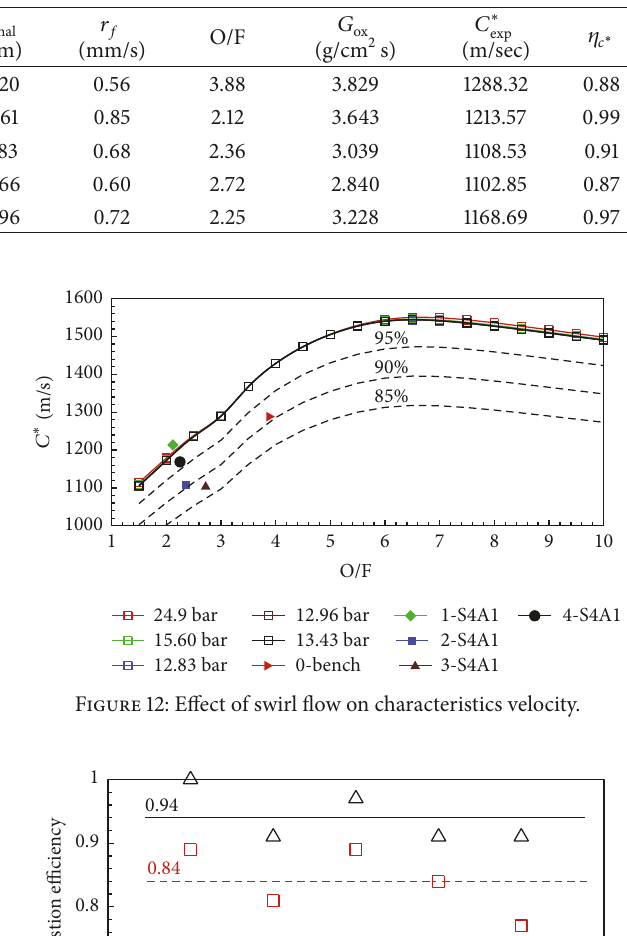
Figure 11: Effect of swirl flow on regression rate.